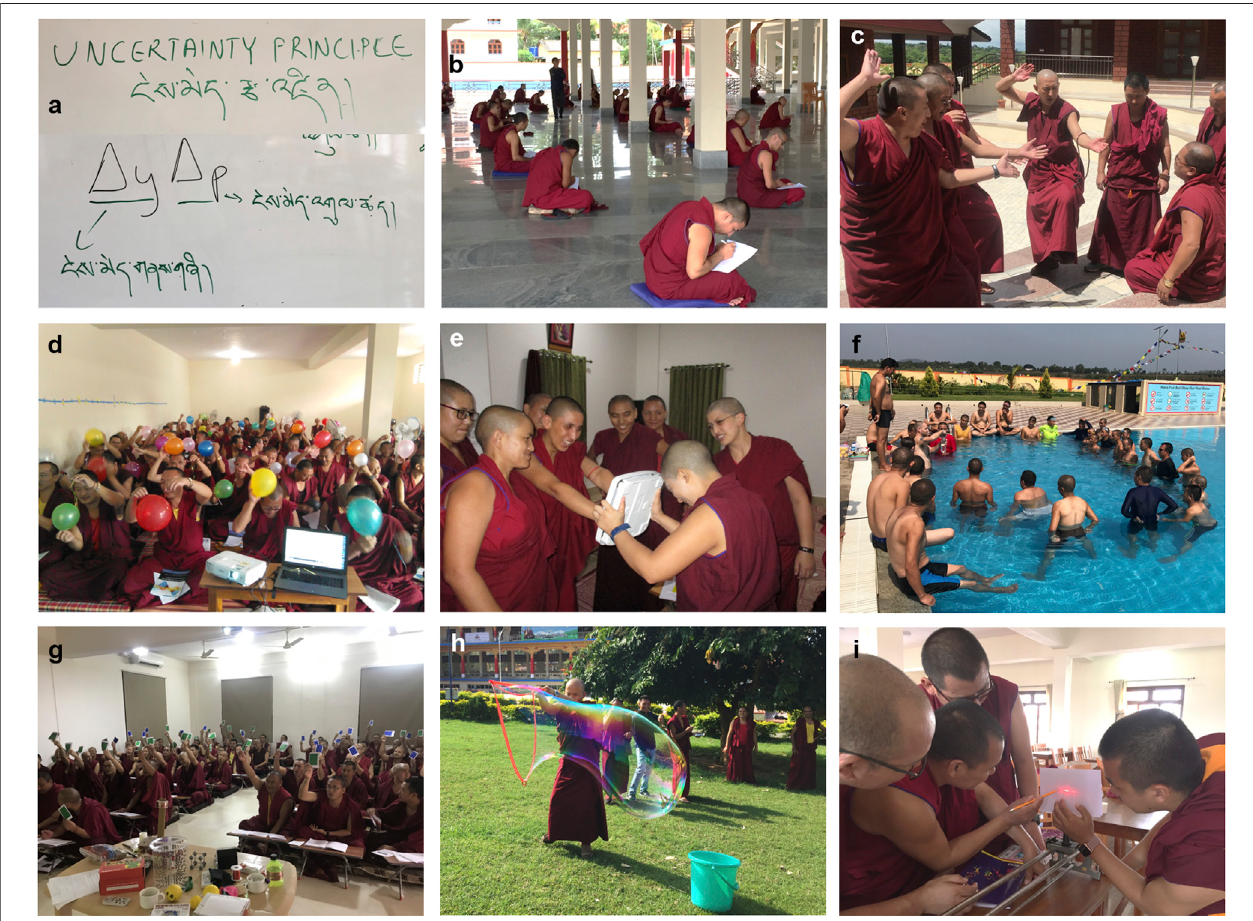
FIGURE 1 | (A) Tibetan translations of physics terms. (B) At the end of 2-weeks course, a written, translated exam for each year of the program assessed the course. (C) Debates occurred nearly every evening, a key component of monastic education. (D) Scholars learn about static electricity with balloons. (E) Female year 2 scholars experimenting with forces as indicated on a scale. (F) An outdoor class on buoyancy in the swimming pool during Year 3. (G) Scholars used colored cards to answerphysics concept questions. (H) Making large bubblestohighlightthin fi lminterference oflight. (G) Year5experiments included measuringdiffraction witha laser